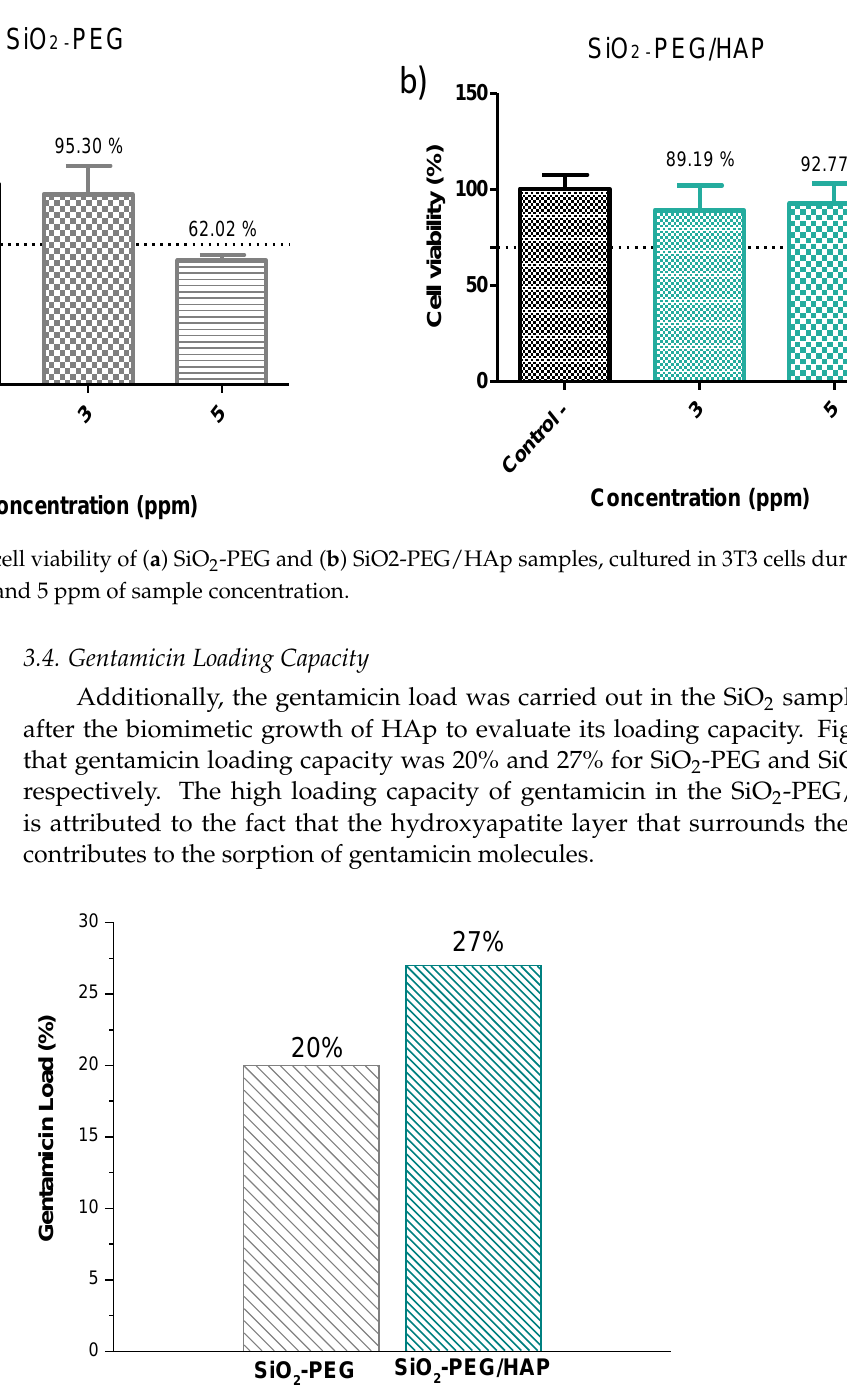
Figure 11. Gentamicin loading capacity of SiO 2 -PEG and SiO 2 -PEG/HAp samples.